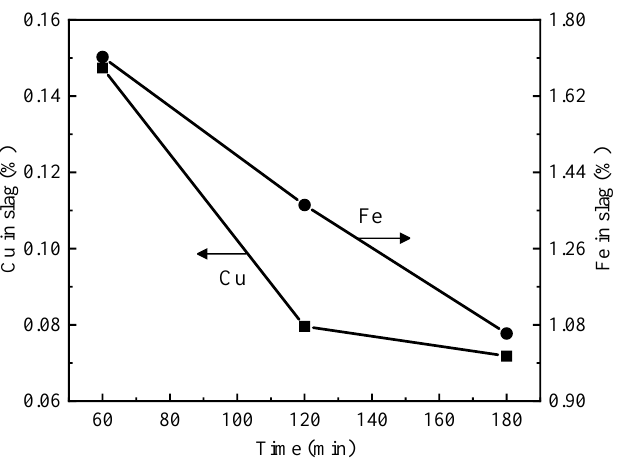
Figure 11. Effect of reduction time on the copper and iron contents in the reduced slag at 1400 °C, 5% CaO and 13% graphite.